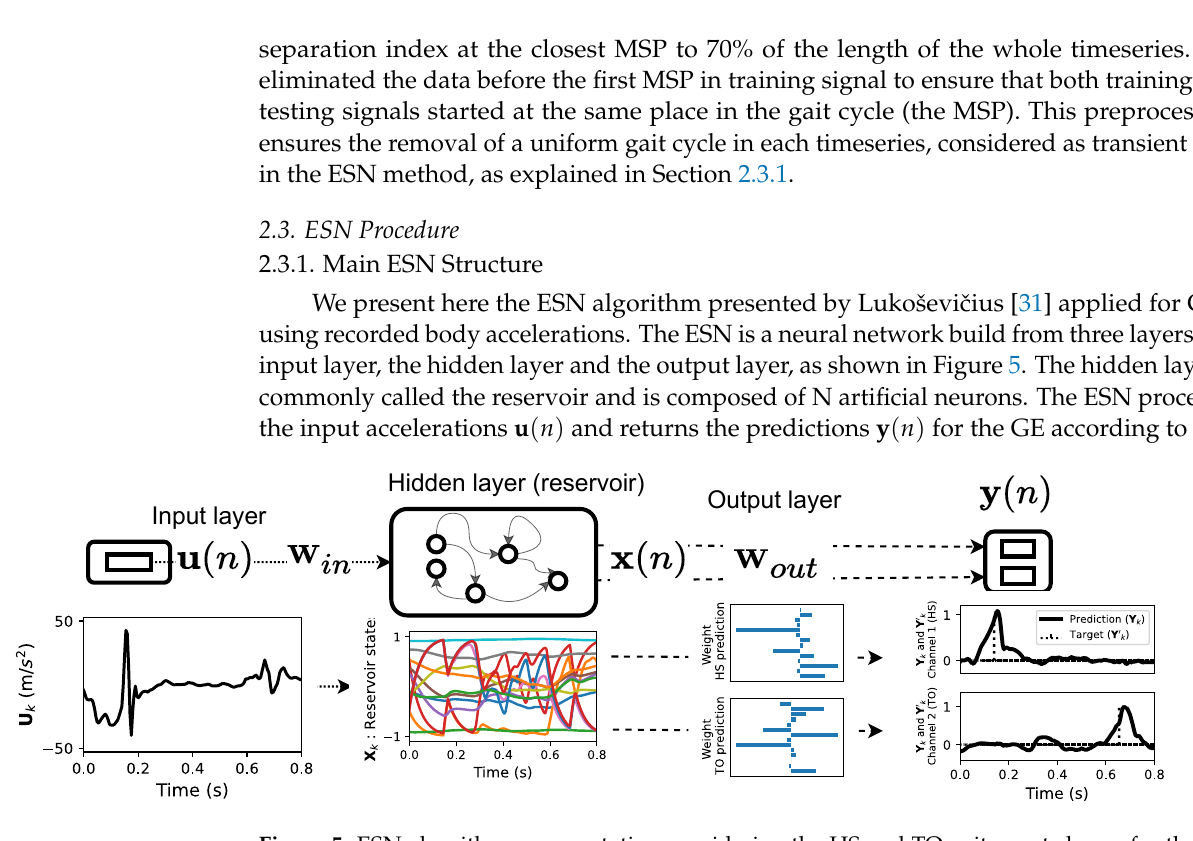
Figure 5. ESN algorithm representation considering the HS and TO gait event classes for the out- put